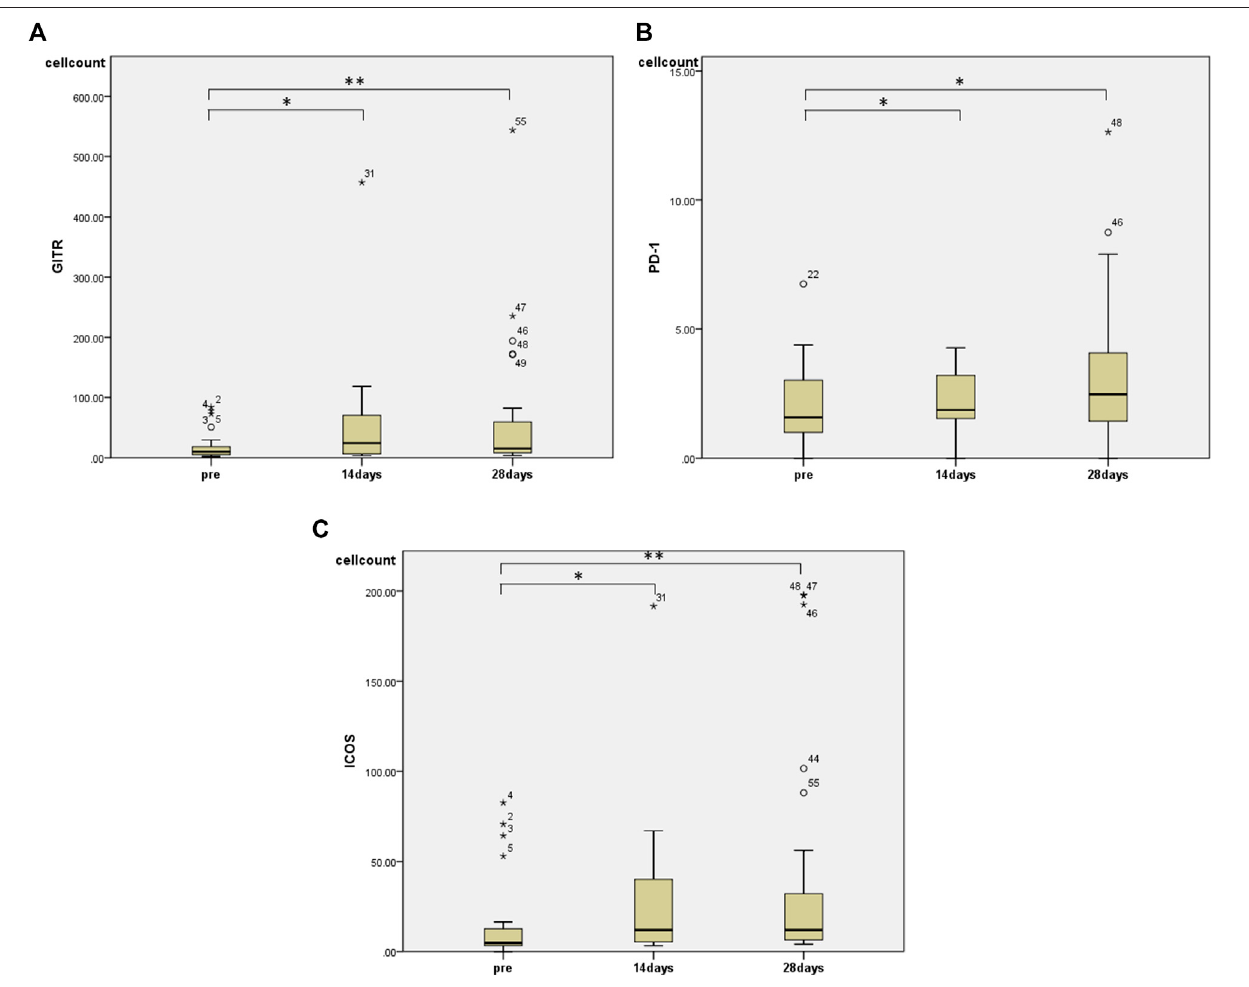
FIGURE4| TheeffectsofHETandKKTonPBMCsubsets.Thesigni fi cantincreasewasobservedin (A) GITR, (B) PD-1,and (C) ICOSatboth14and28 daysafter administration. * p < 0.05; ** p < 0.01.